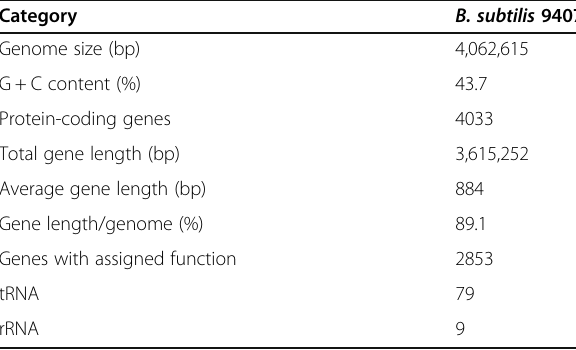
Table 1 General genome features of B. subtilis